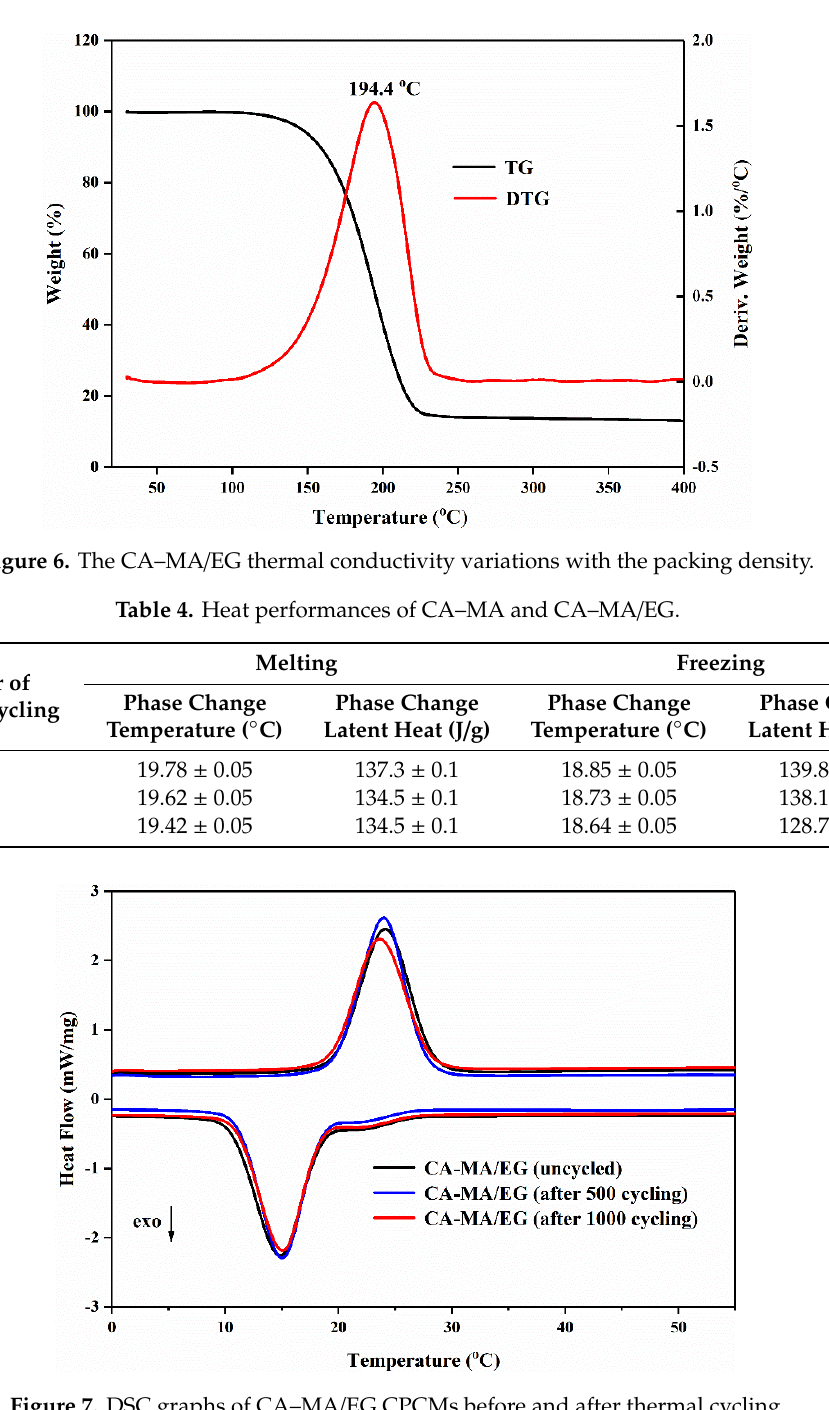
Figure 7. DSC graphs of CA–MA/EG CPCMs before and after thermal cycling.